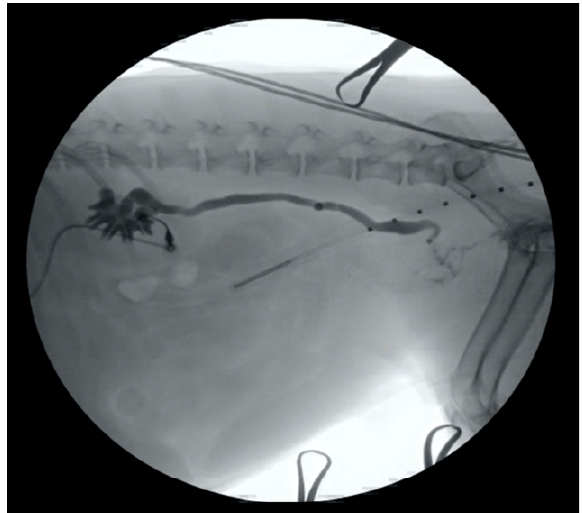
Figure 1. An 18-gauge over-the-needle catheter has been inserted into the renal pelvis of a dog in lateral recumbency, and a contrast nephroureterogram has been performed using fluoroscopic guid- ance.